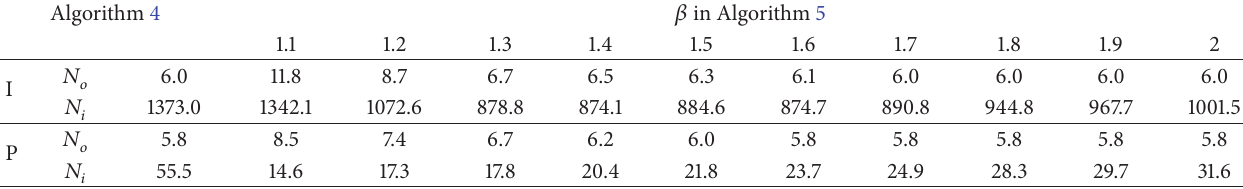
Table 1: Averaged total numbers of outer and inner